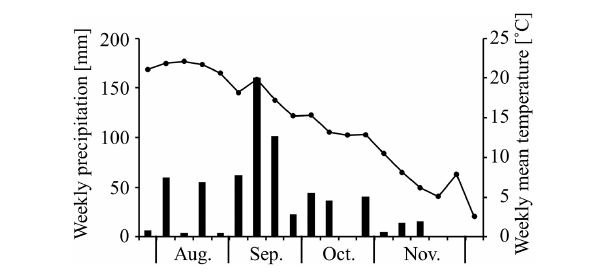
FIGURE 1 | Temporal changes in weekly precipitation (solid bars) and weekly mean air temperature (solid circles) during the study period.